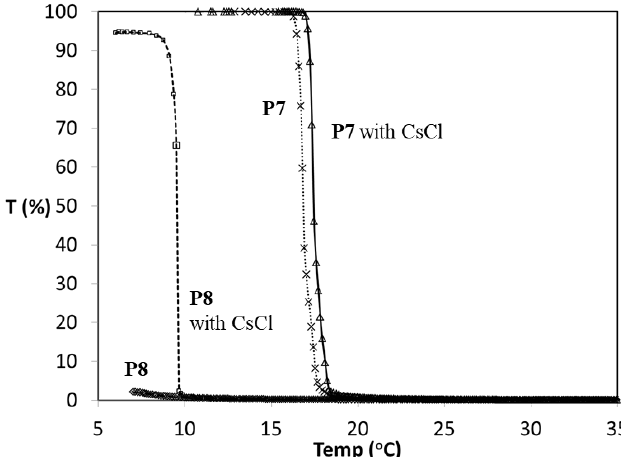
Figure 2. Transmittance of copolymers (0.5 wt %) in water in the absence/presence of CsCl.